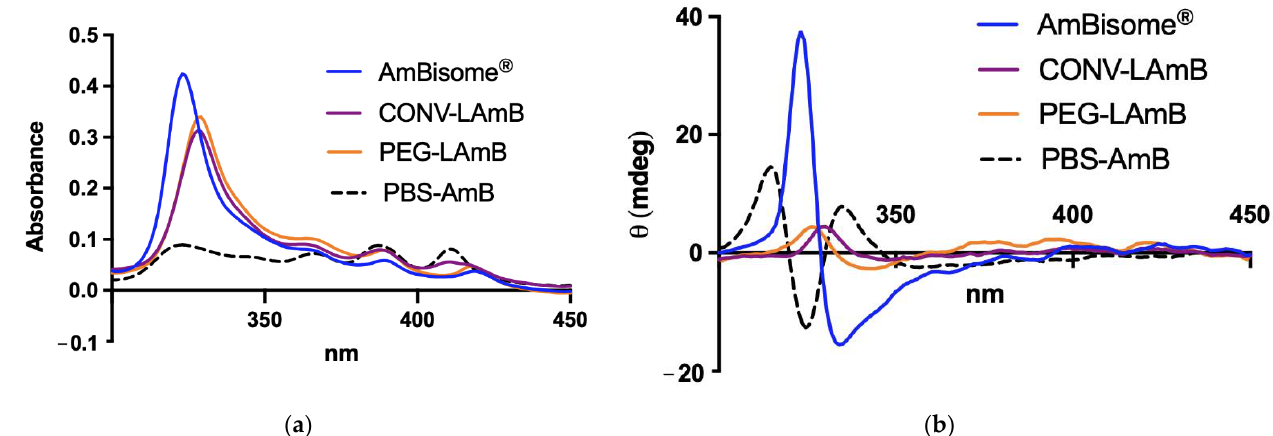
Figure 2. Characterization of AmB aggregation state by: ( a ) spectrophotometry and ( b ) circular dichroism in conventional (CONV-LAmB) and PEGylated (PEG-LAmB) liposomal AmB, in comparison to AmBisome ® . PBS-AmB is a solution of AmB prepared in PBS without liposomes, using the same process of preparation of the liposomal formulation, except for the freeze-drying step.